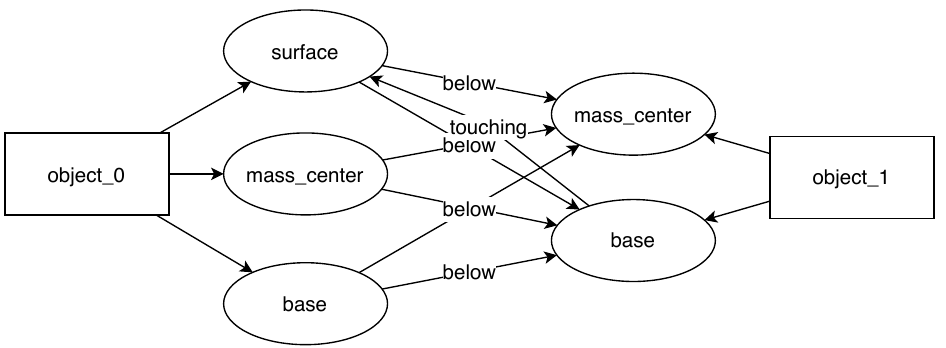
Figure 7. A graph representing learned skill requirements for the task of stacking